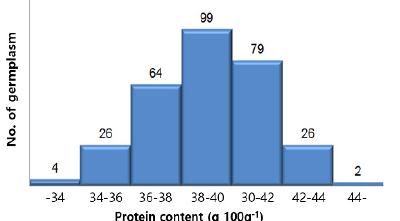
Figure 1. Frequency distributions of protein contents in 300 soybean germplasms.